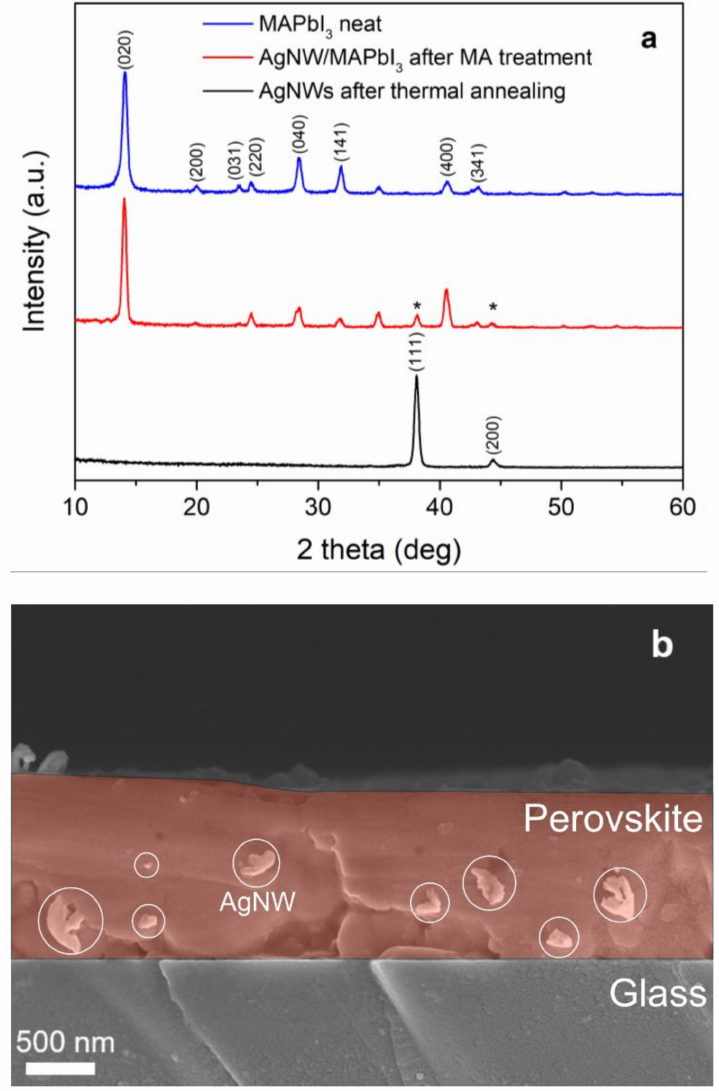
Figure 4. ( a ) XRD patterns of neat MAPbI 3 , AgNW/MAPbI 3 , and AgNW network layers. ( b ) Cross- sectional SEM image of AgNW/MAPbI 3 layer. The star signs (*) in the AgNW/MAPbI 3 XRD pattern indicate the reflections from (111) and (200) planes of silver